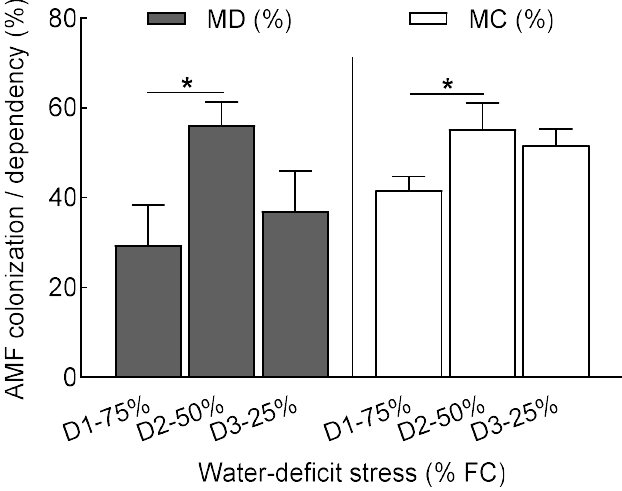
Figure 1. Mycorrhizal colonization rate (MC (%), white bars) and mycorrhizal dependency (MD (%), grey bars) of C. spinosa +AMF seedlings at three levels of water-deficit conditions (D1—75%, D2—50% and D3—25% FC). The bar chart with error bars represents the means and SD of three replicates. Asterisks indicate significant differences between water-deficit stress treatments (α = 0.05), as determined using one-way ANOVA, followed by post hoc Tukey’s tests (*, p < 0.05).